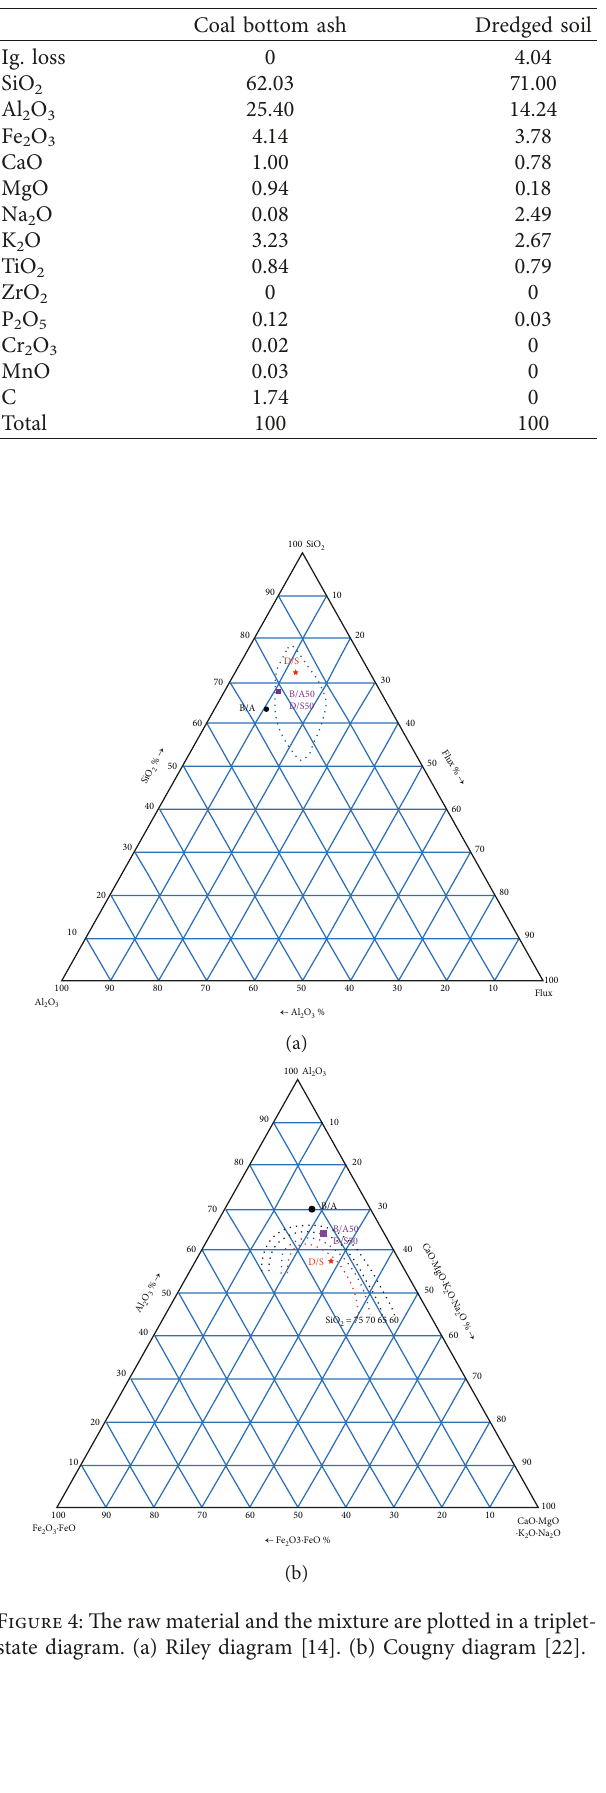
Table 2: Chemical compositions of raw